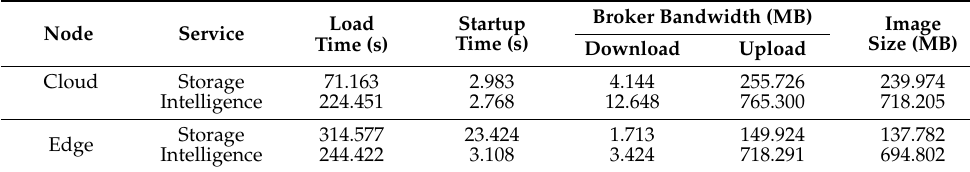
Table 10. Microservice deployment performance.